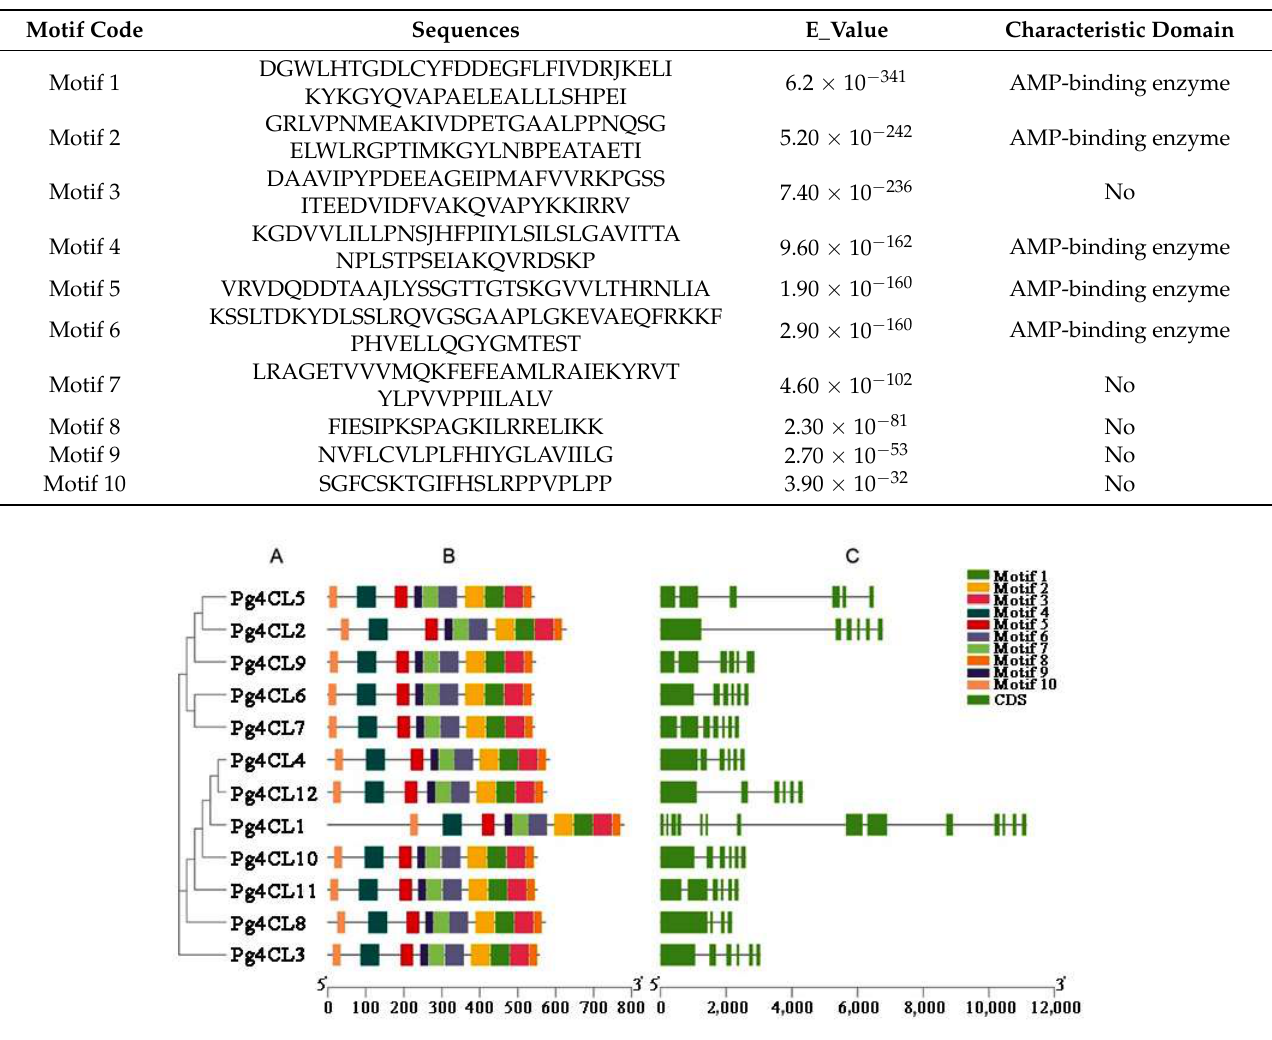
Figure 6. Phylogenetic tree, conservative protein motifs and gene structure of the Pg4CLs in pomegranate. ( A ) The phylogenetic tree of 12 Pg4CLs. ( B ) Conserved motifs in the 12 Pg4CLs. The motifs were identified by the MEME Suite. Different conserved motifs, numbers 1–10, are displayed in different colored boxes. ( C ) Gene structures of the 12 Pg4CLs